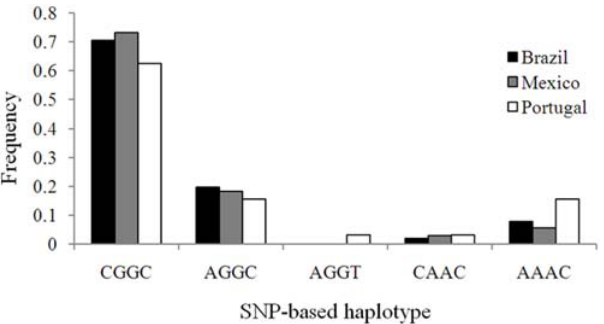
Figure 2. Frequency of SNP-based Haplotypes. Frequency of SNP- based, intragenic, haplotypes of ATXN10 , in Mexican, Brazilian and